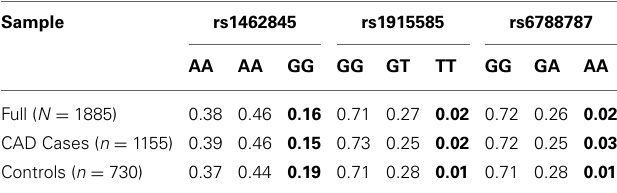
Table 5 | Genotype frequencies by sample and case